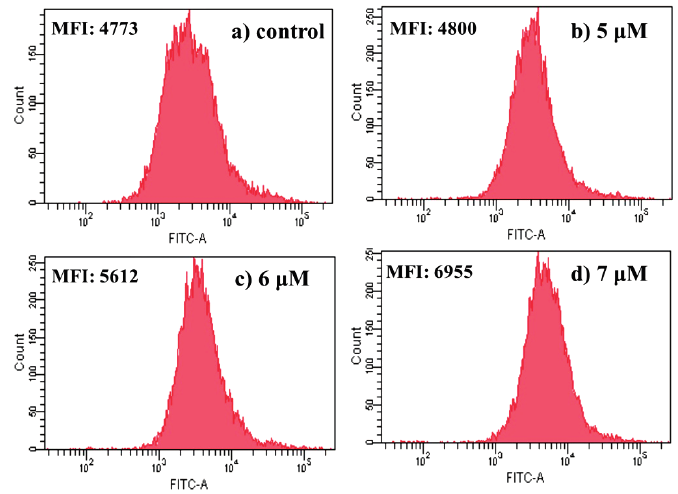
Figure 7. Effect of 4a on intracellular free Ca 2+ in HepG2 cells: ( a ) control group; ( b ) 5 μ M; ( c ) 6 μ M; and ( d ) 7 μ M. After being treated with 5.0, 6.0 and 7.0 μ M 4a for 72 h, cells were determined by flow-cytometric analysis stained with Fluo-3AM for 30 min. Results are expressed as mean fluorescent intensity